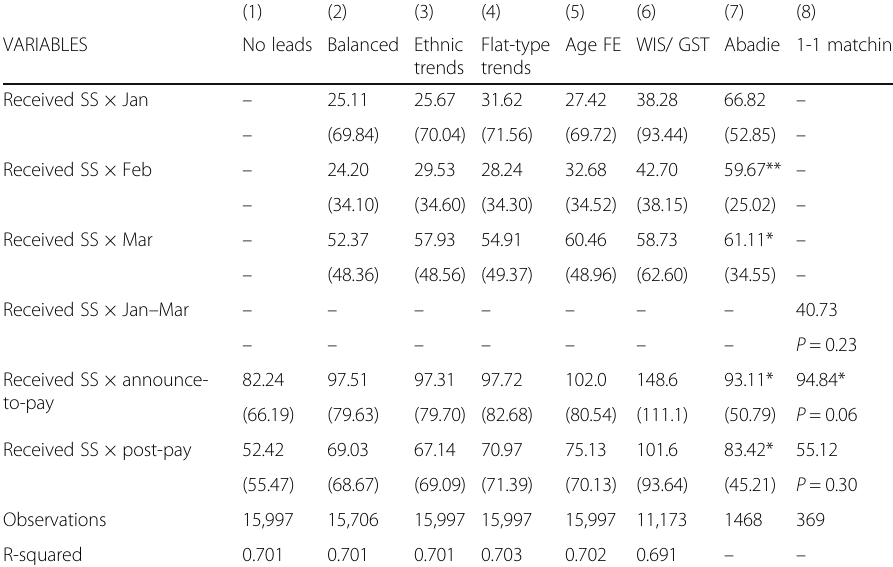
Table 12 Robustness check for impact of receiving SSS payouts on amount of income received from